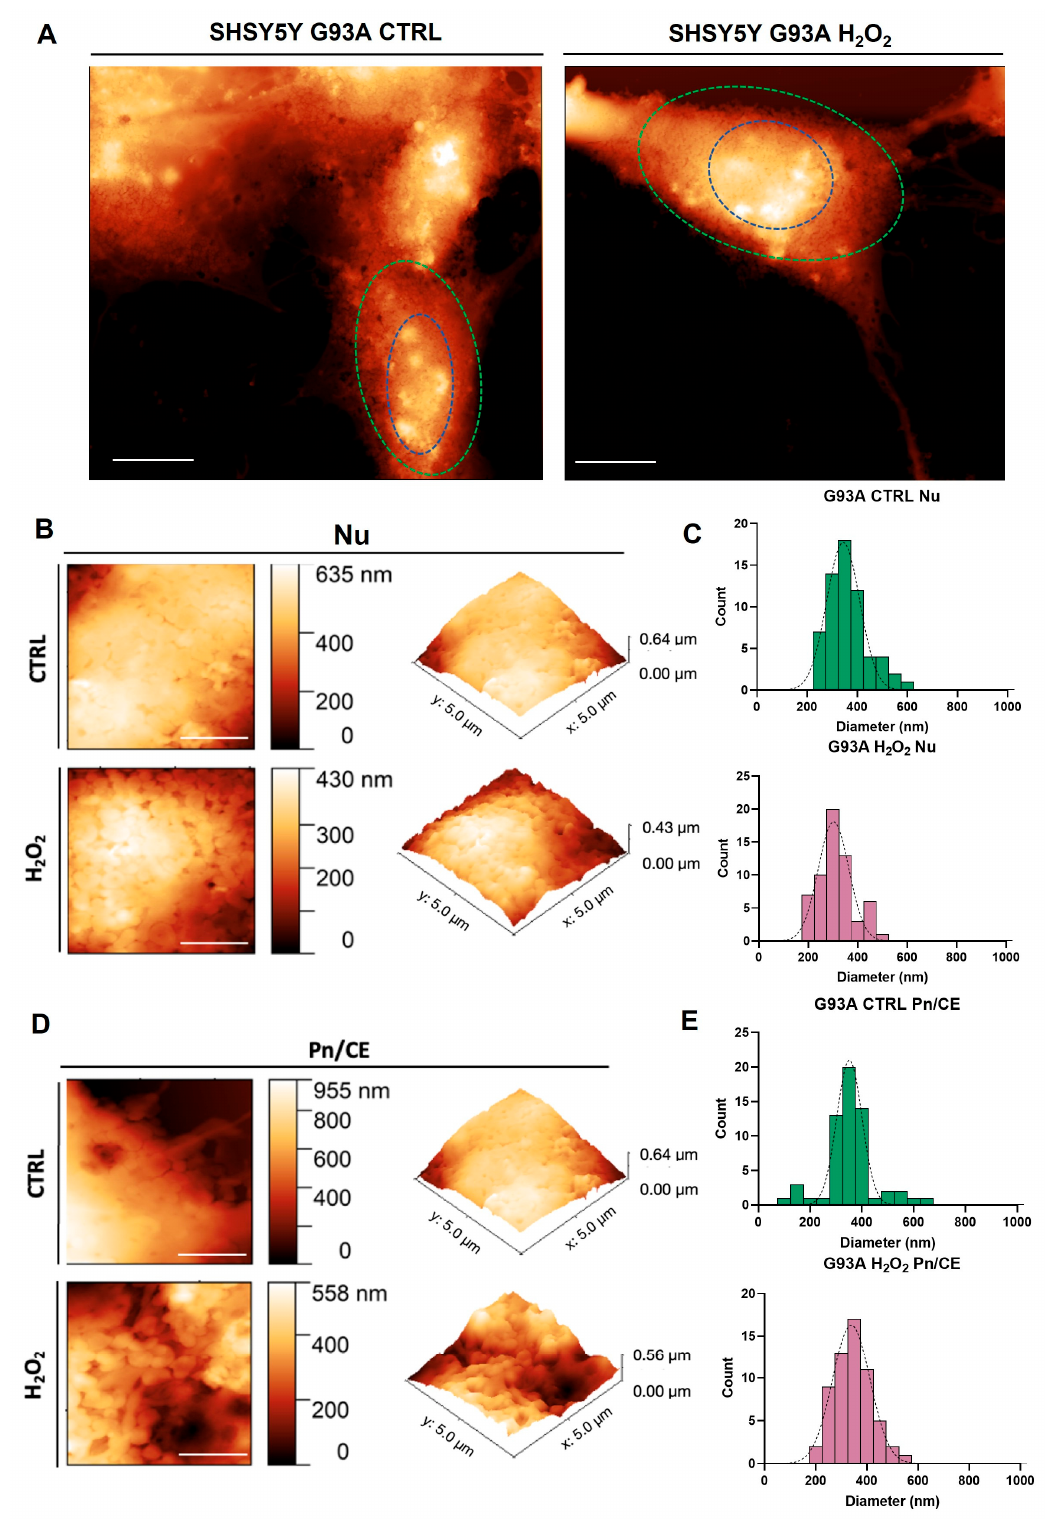
Figure 5. Mapping of the surface of CTRL and H 2 O 2 SOD1-G93A SH-SY5Y cells ( A ) in the nuclear zone ( B ) and perinuclear-to-cellular edge regions ( D ), with relative 3D reconstructions and size distributions ( C , E ), Ntot = 62, 60, 60, and 60. Scale bars = 10 µ m for whole cells micrographs; 1 µ m for magnifications of the mapped regions. Nu = nuclear zone (blue circles); Pn/CE = perinu- clear-to-cellular-edge regions (green